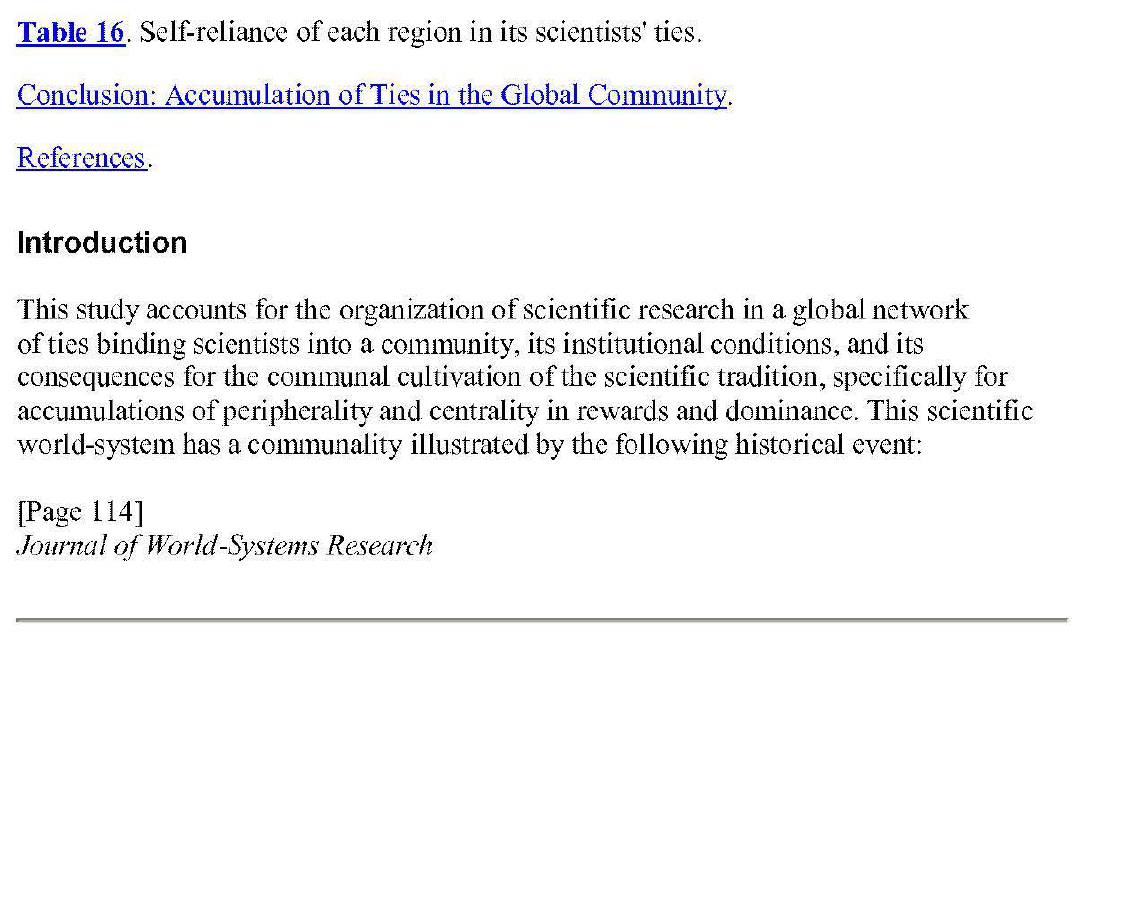
Table 8. Articles coauthored between nations, 1973 and 1986. Table 9. Articles authored within and among nations. Circulation of Knowledge Around the World . Table 10. Citations among authors. Table 11. Influence on scientists from peers. Desire for Rewards and Emulation Around the World. Table 12. Recognition desired by scientists from colleagues. Table 13. Emulation by scientists of colleagues. Accumulat ion of Rewards and Dominance in the Center . Table 14. Research in each region and its centrality. Outwardness and Accumulation of Self-reliance in the Center . Table 15. Outwardness of each region in its scientists' ties. Table 16. Self-reliance of each region in its scientists' tics. Conclusion: Accumulat ion of Ties in the Global